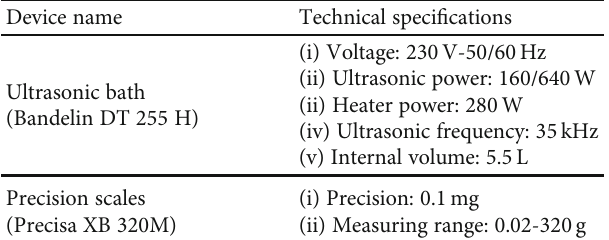
Table 2: Devices and technical features used in preparing nano fl